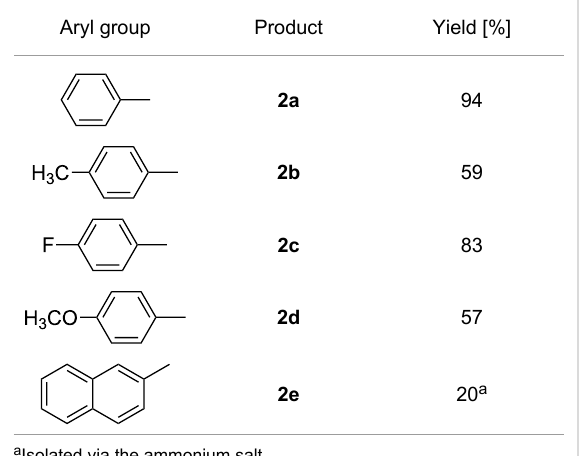
Table 1: Prepared compounds 2a–e with yields. Aryl